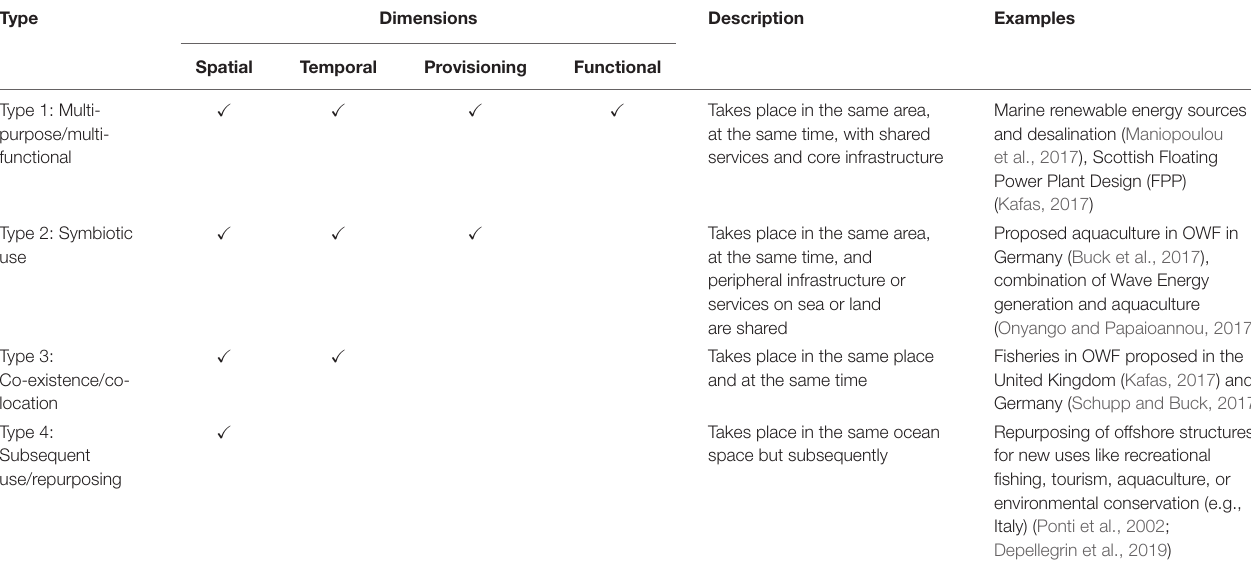
TABLE 1 | Typology of ocean multi-use with descriptions and examples given for each identified type.